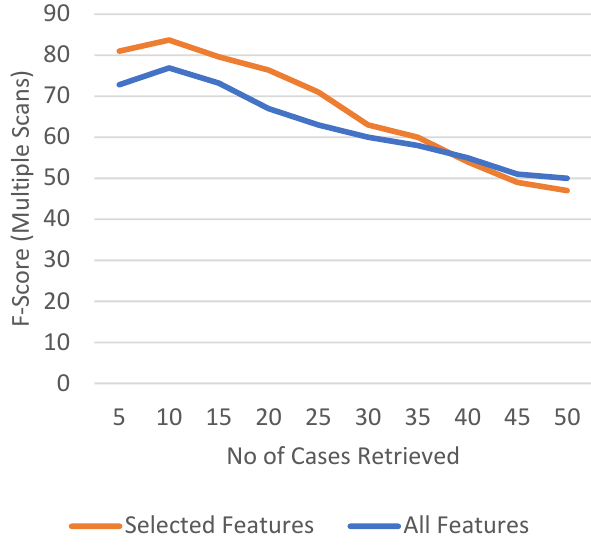
Figure 9. Comparison of selected features for multiple scans.